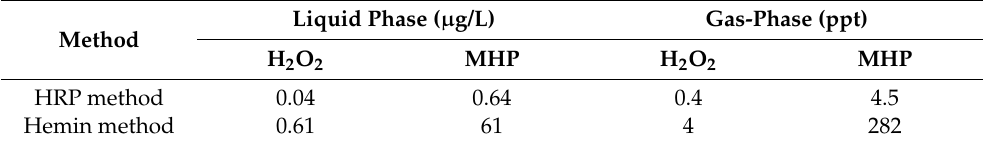
Table 1. Detection limits of H 2 O 2 and MHP in liquid and gaseous phases obtained by two methods.